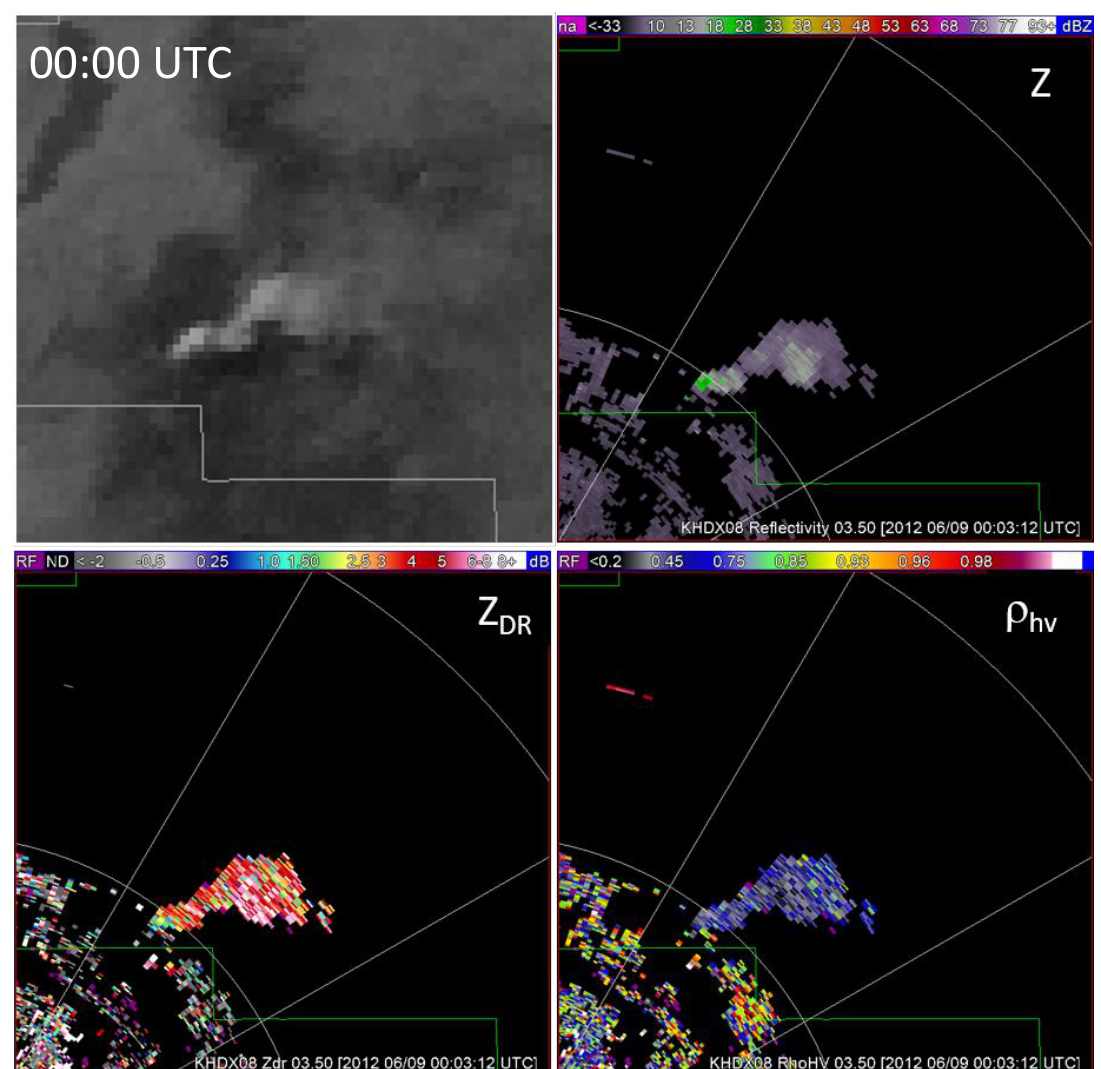
Figure 13. Little Bear fire on June 8 at 1800 mountain daylight timeindicated on the National Aeronautics and Space Administration ( NASA) satellite photo (upper left). Field of reflectivity Z from the WSR-88D (Holloman Air Force Base NM, code designation KHDX) at the same time. Field of differential reflectivity, Z DR . Field of the correlation coefficient, ρ hv . The elevation angle is 3.5° and time is 23:56 UTC. The range rings are at 30 and 60 km.